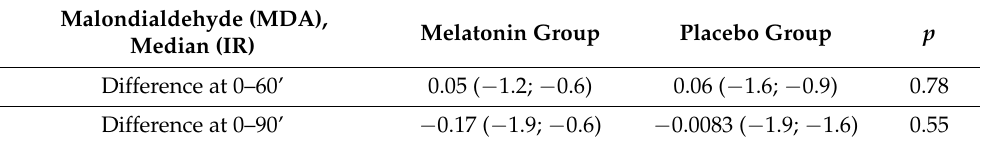
Table 3. Quantification of malondialdehyde (MDA), at 60’ and 90’ after melatonin/placebo adminis- tration in DBD donors. IR, Interquartile Range.